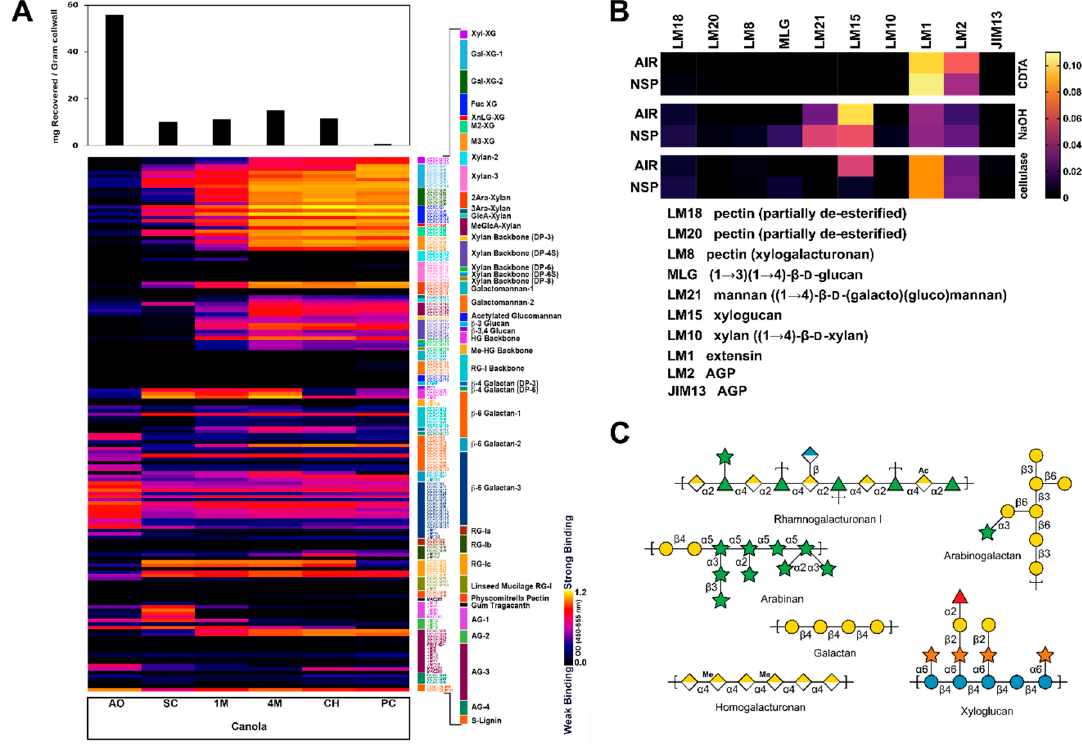
Figure 1. Cell wall glycome profiling of canola meal. Canola meal (CM) plant cell wall extracts were analyzed through an enzyme-linked immunosorbent assay (ELISA)-based screen against a collection of ( A ) 155 plant cell wall or ( B ) 10 glycosidic linkage-specific glycan-directed monoclonal antibodies (mAbs) analysed through MicroArray Polymer Profiling (MAPP). ( A ) Each column represents the different fractions from polysaccharide extractions of the CM plant cell wall: Ammonium oxalate (AO); sodium carbonate (SC); 1 M KOH (1M); 4 M KOH (4M); chlorite (CH); post-chlorite (PC). The colour of each element in the map reflects the strength of the ELISA signal (black = no binding, yellow = strong binding). The antibodies are grouped according to the epitopes that they recognize (bar at the right of the profiles). Each row reflects the binding pattern of a single mAB against the series of CM extracts. The bar graphs above the glycome profiles show the amounts of carbohydrate present in each extract. ( B ) Each column represents the binding pattern of a mAb, as indicated. Each row reflects the different fractions of polysaccharide extractions by CDTA, NaOH, or cellulase treatment for CM alcohol insoluble residue (AIR) or non-starch polysaccharide (NSP). ( C ) Based on the results from the ELISA-based polysaccharide composition screens, schematics were drawn for the dominant polysaccharides found in CM. Monosaccharide symbols follow the SNFG (Symbol Nomenclature for Glycans) system [57].